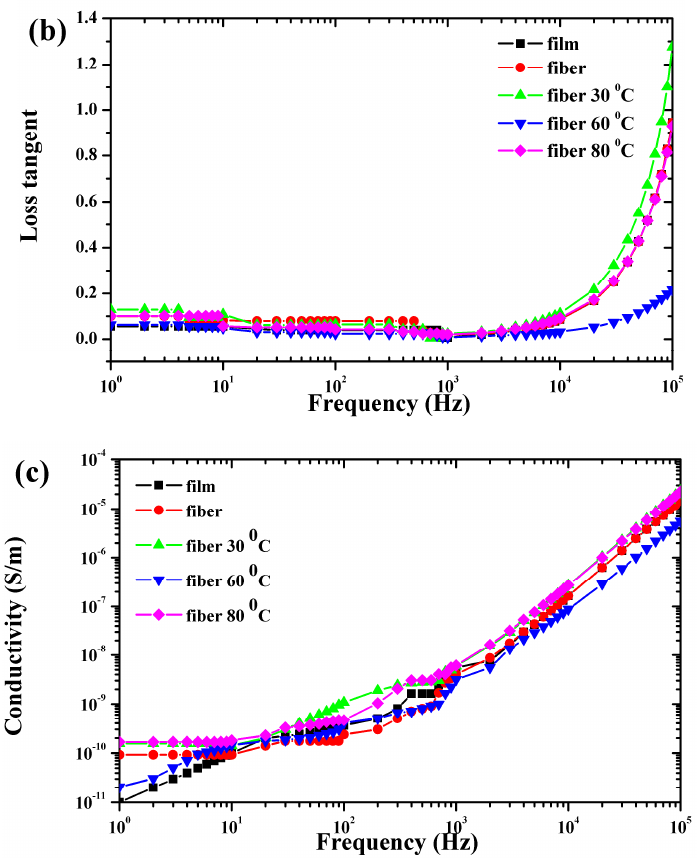
Figure 7. Variation of the dielectric constant ( a ), loss tangent ( b ) and AC conductivity ( c ) with frequencies from 10 0 to 10 5 Hz for the film, fibers, and compressed fiber mats.